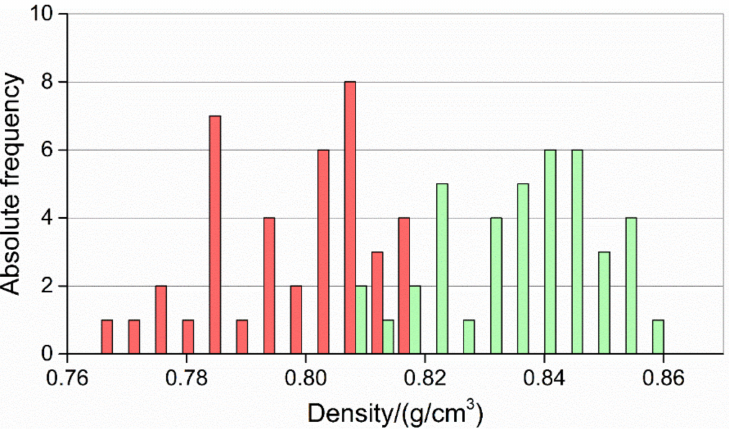
Figure 19. Distribution of density values for IM (red) and µ IM